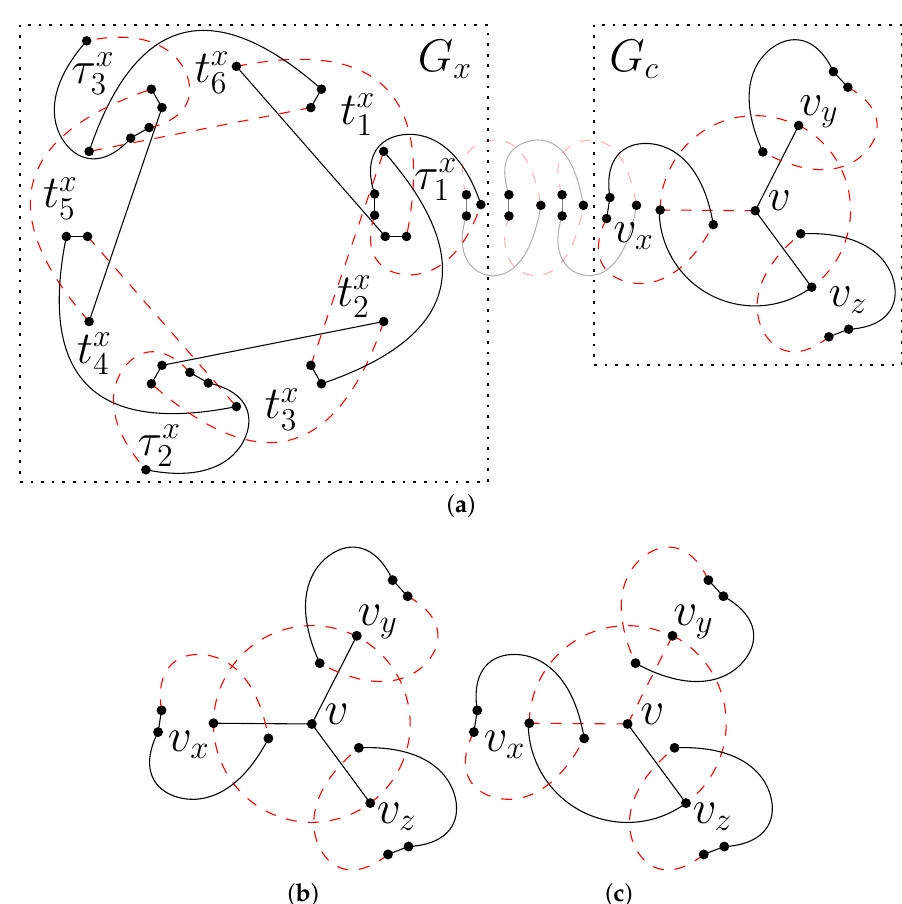
Figure 3. ( a ) The variable gadget G x for a variable x is represented in the left dotted box. The clause gadget for a clause c is represented in the right dotted box. The chain connecting G x to G c is represented with lighter colors. The removed edges are dashed red. ( b ) All variables are False . ( c ) At least two variables are True